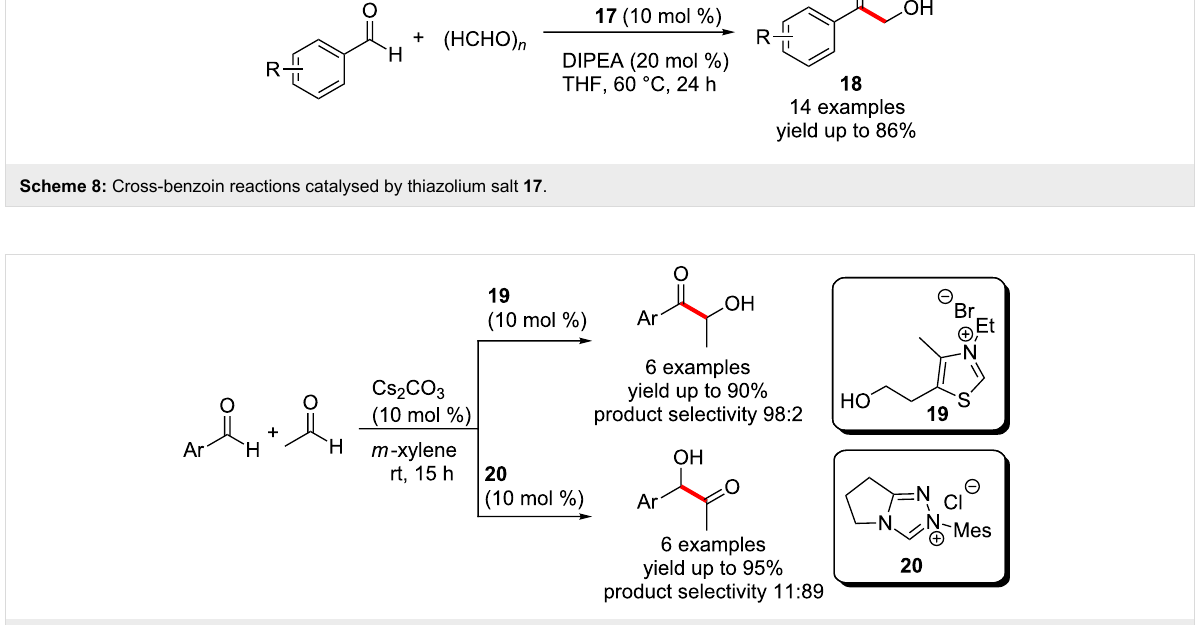
Scheme 9: Catalyst-controlled divergence in cross-benzoin reactions.